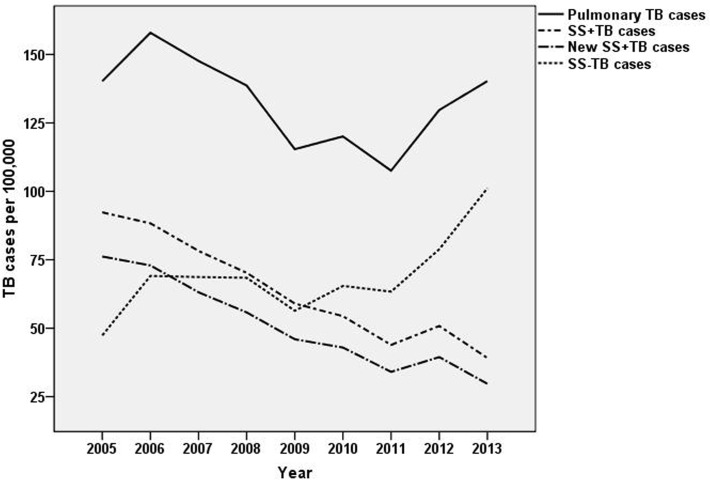
The trend of pulmonary TB incidence from 2005 to 2013.